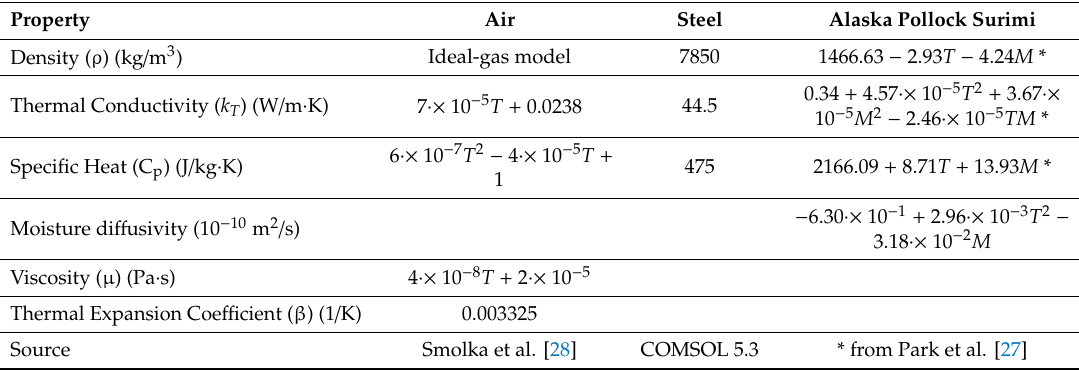
Table 1. Thermal and physical properties of air, steel, and Alaska pollock surimi.